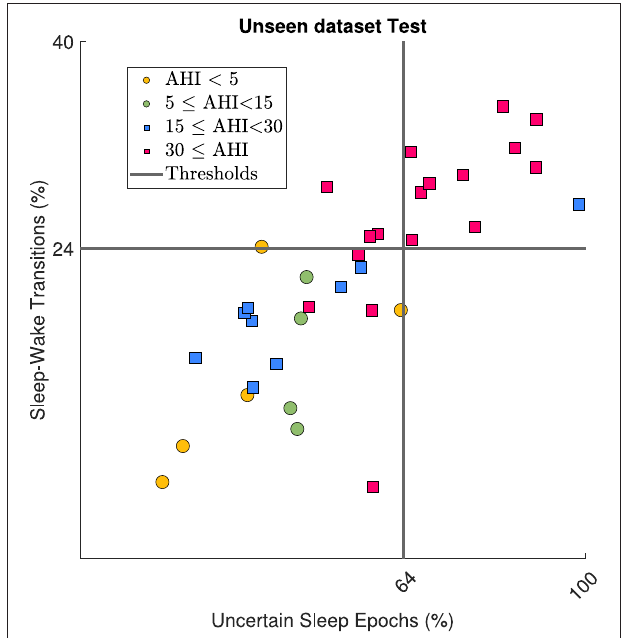
FIGURE 5 | Application of two detection metrics on dataset Test where circles represent patients with AHI < 15 and squares AHI > 15. Gray lines represent the corresponding metric thresholds. Severe OSA patients (AHI > 30) were detected correctly by the metrics, as